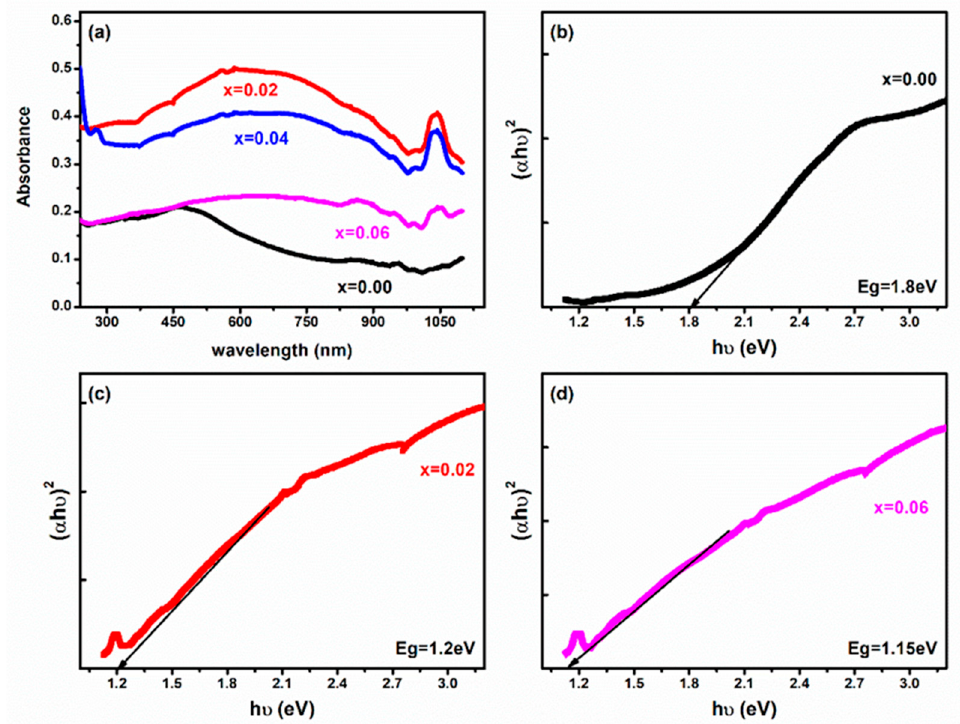
Figure 6. ( a ) UV-visible absorption spectra of [BiFe 1 − x Li x O 3 ]-graphene nanocomposite. ( b – d ) Tauc Plot (( α h ν ) 2 vs. h ν ) of [BiFe 1 − x Li x O 3 ]-graphene nanocomposite.